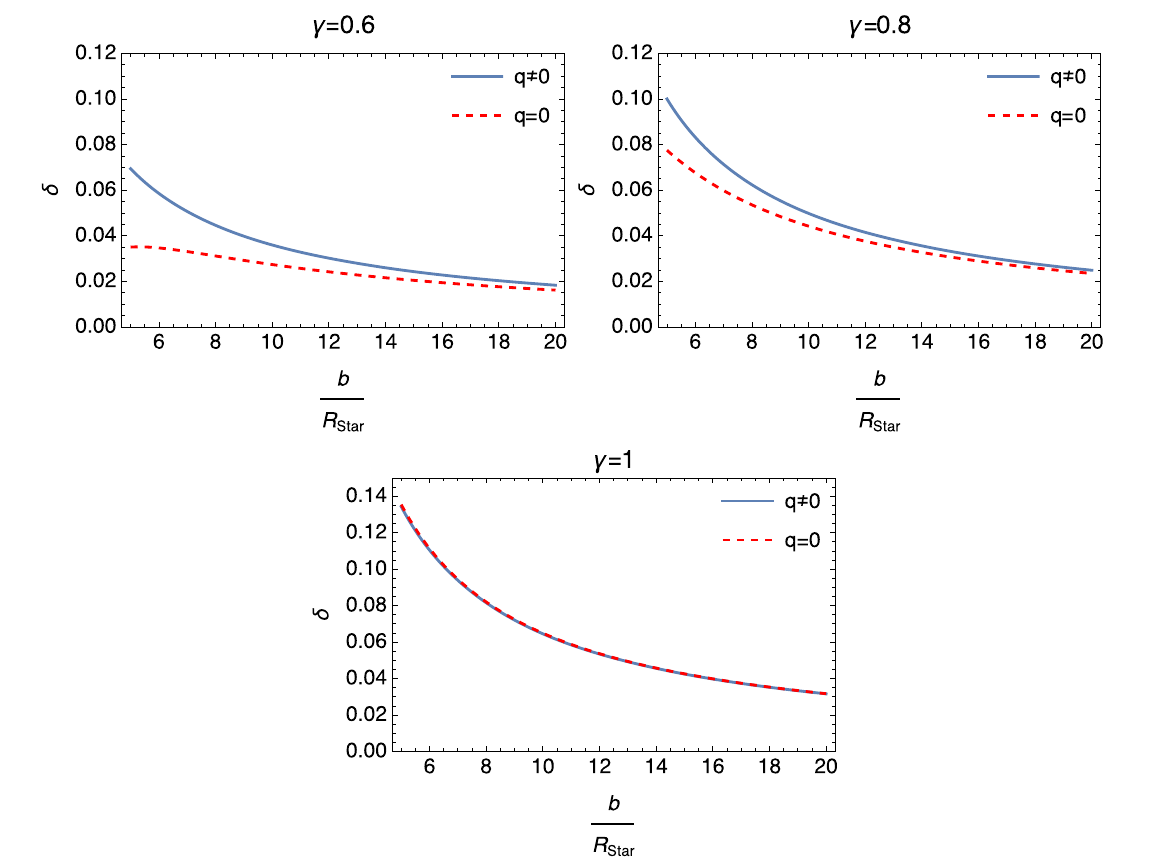
Fig. 5 δ versus x plot for the Her X − 1 star for the charged (solid line)/uncharged (dashed line) cases